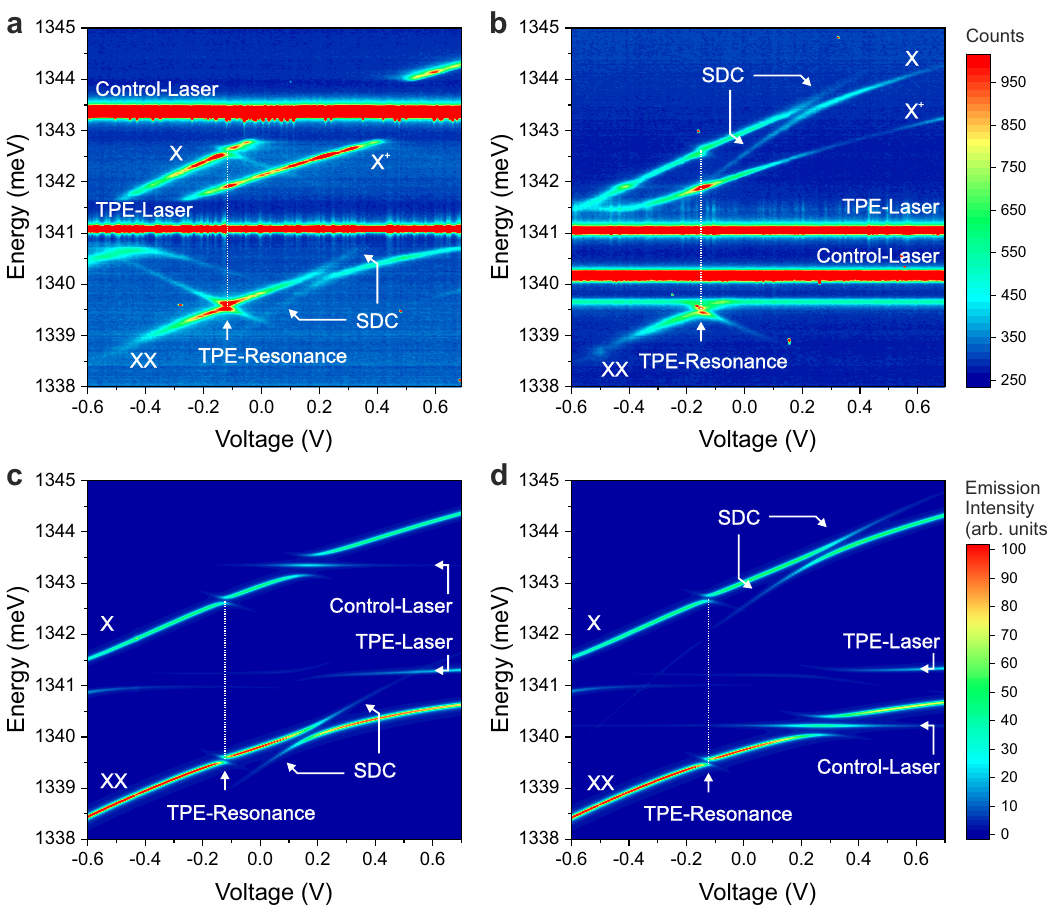
Fig. 3 Stimulated down-conversion (SDC) in a single quantum dot. a Experiment with blue-shifted control laser: The SDC emission appears on the low- energy side with the expected Stark shift and an avoided crossing with the XX-line ( P TPE = 10 mW, P Control = 1.5 mW, T int = 2 s, ħ Ω 0 = 0.198 meV). b Experiment with red-shifted control laser: The SDC emission appears on the high-energy side with the expected Stark shift and an avoided crossing with the X-line ( ħ Ω 0 = 0.189 meV). c Theoretical results for case a , taking into account the experimental conditions. d Theoretical results for case ( b ).